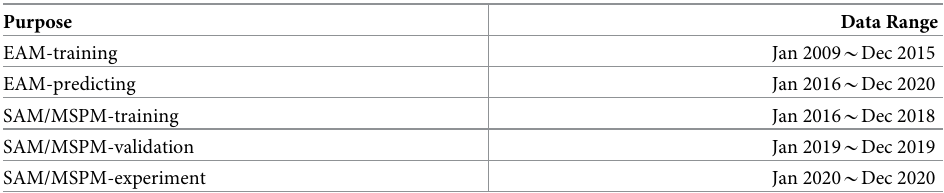
Table 2. Date ranges of the